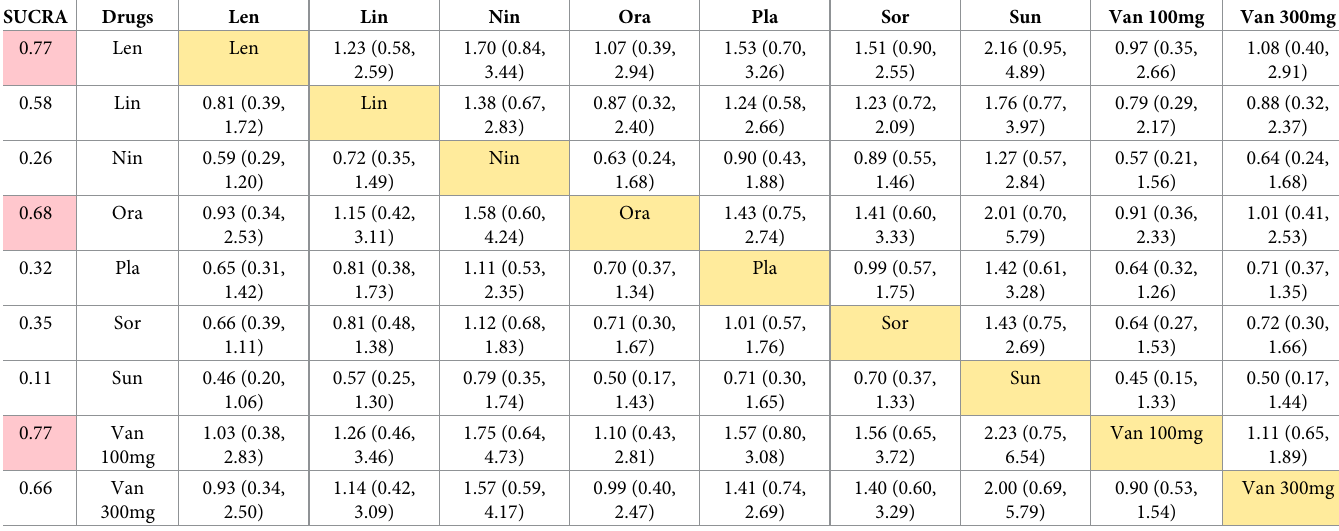
Table 3. Network meta-analyses for PFS (Findings are expressed as HR (95% CrI), use of random-effect model).